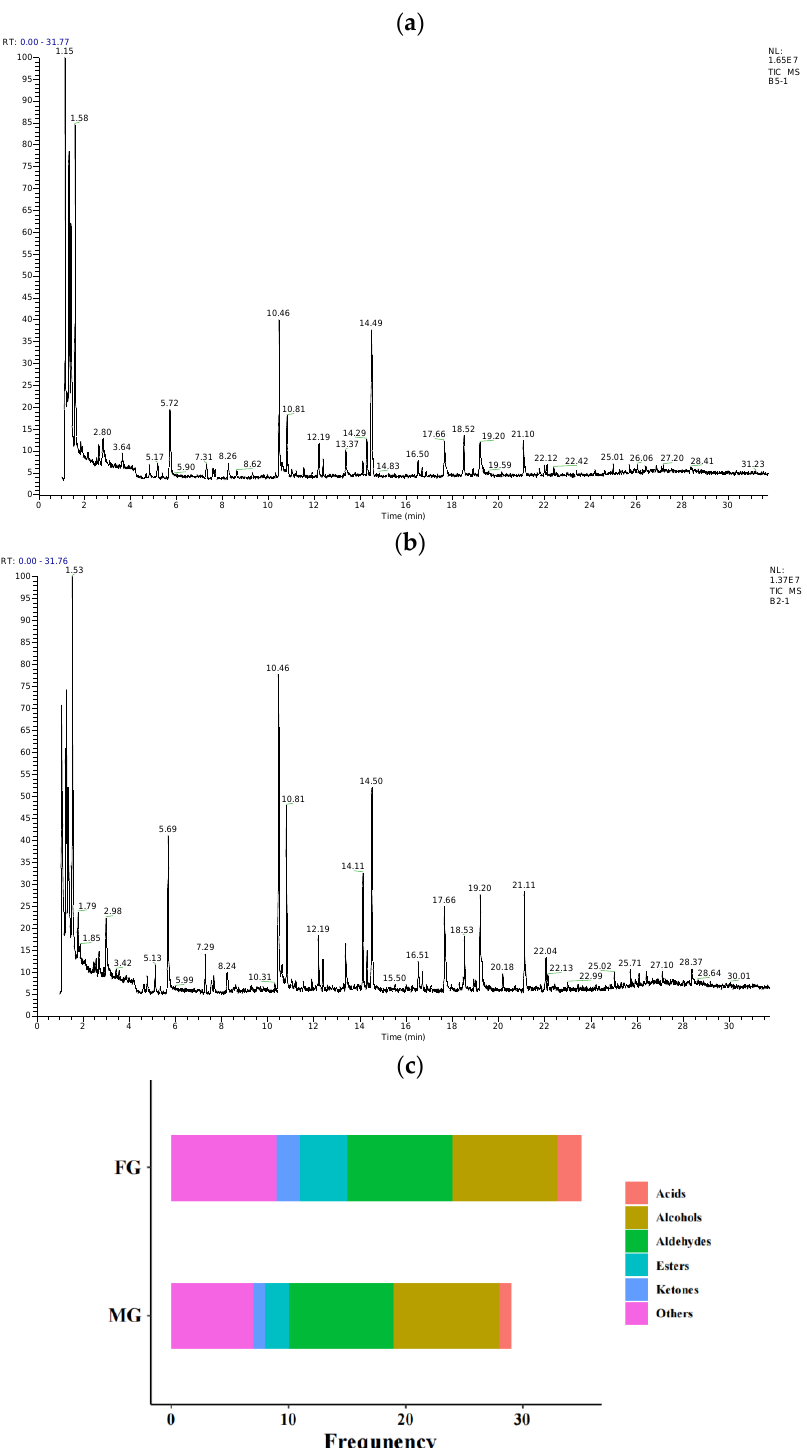
Figure 4. ( a , b ) Chromatogram of volatile flavor compounds. ( a ) FG group. ( b ) MG group. ( c ) Species of volatile flavor substances. FG group, flatland-grazing group; MG group, mountain-grazing group.